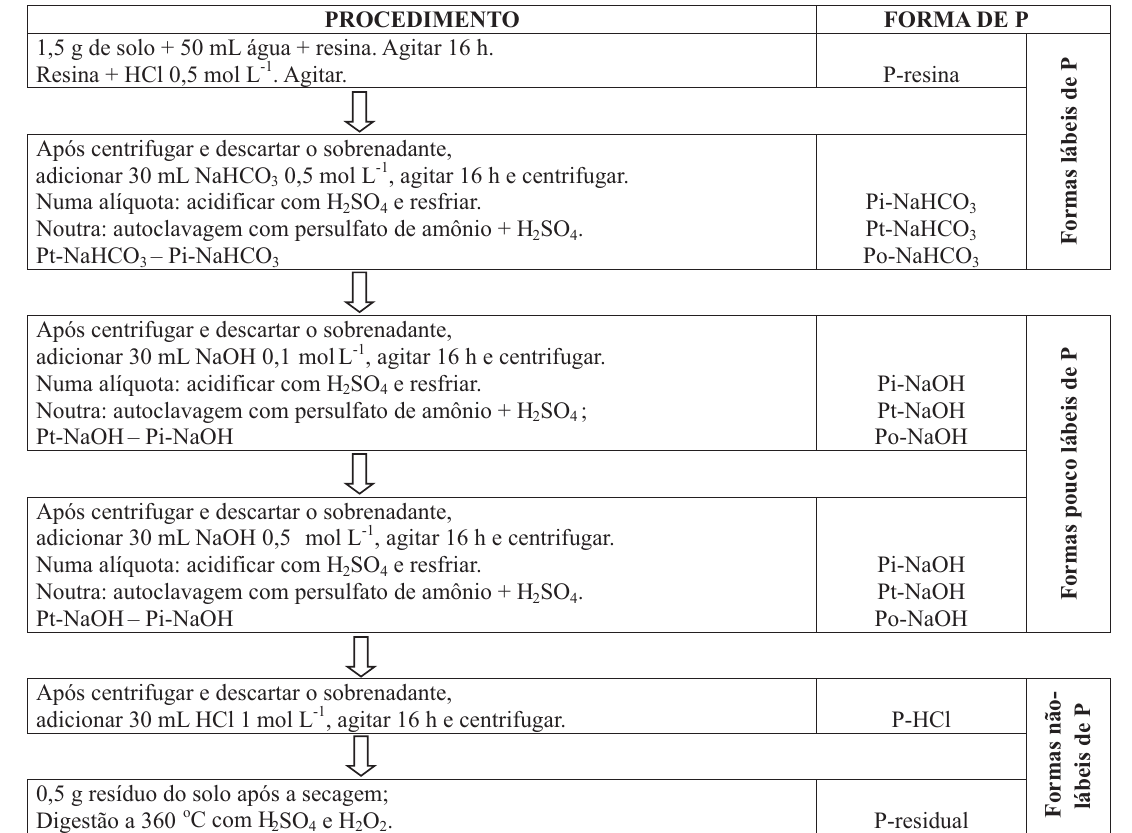
Figura 1. Procedimento simplificado de fracionamento seqüencial de fósforo (modificado de Hedley et al.,